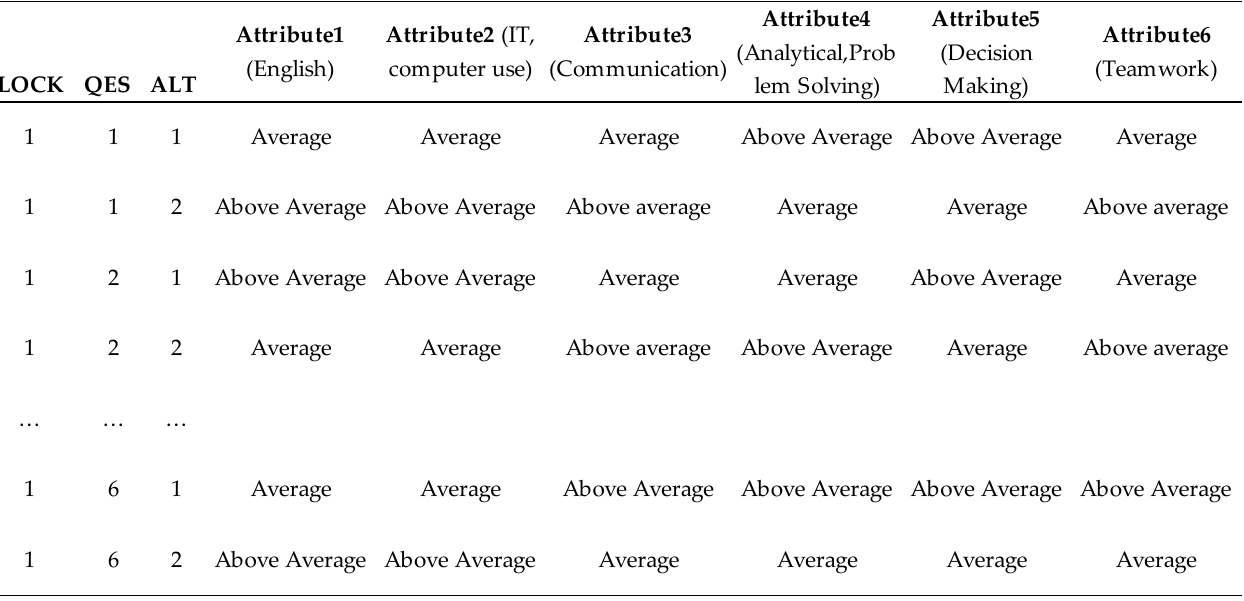
Figure 2. Support matrix for the conjoint questionnaire. The first column indicates the block, the second column indicates the choice task inside the block. Within each block, there are six questions. Column 3 specifies the alternative number. The last six columns represent the levels defining the six criteria. Therefore,